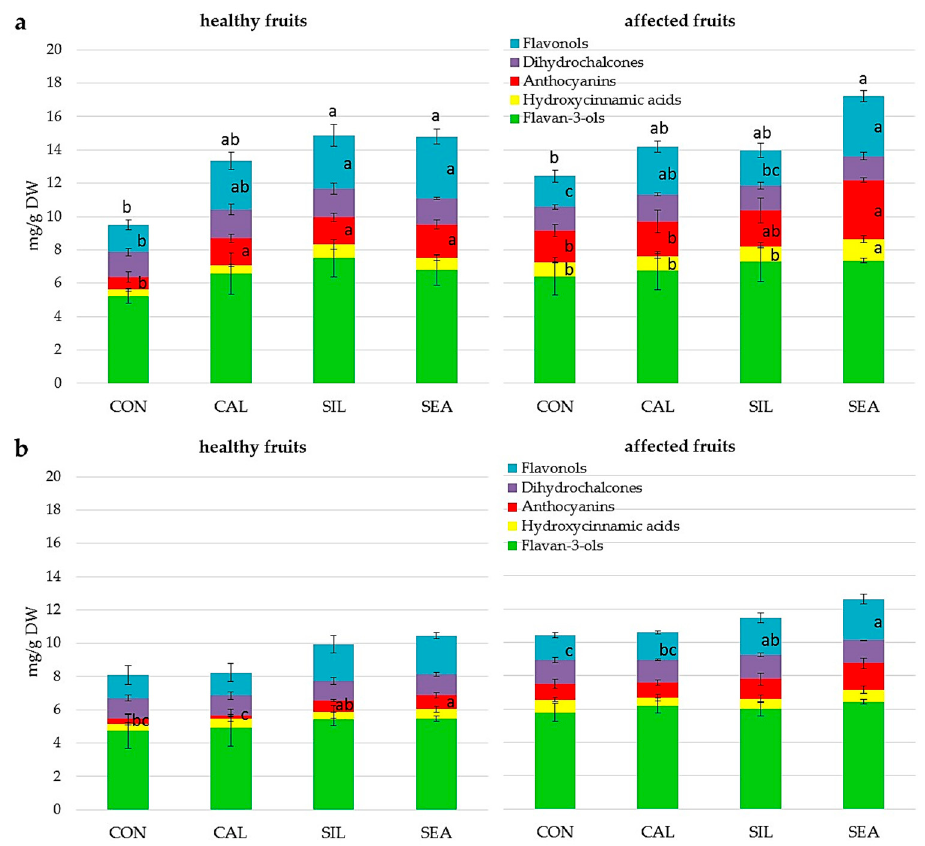
Figure 5. Phenolic content in apple skin after storage in healthy and affected fruits in site 1 ( a ) and site 2 ( b ). Vertical bars indicate mean ± SD ( n = 3). Letters inside bars refer to significant differences among treatments for each single phenolic class, according to Tukey’s HSD post-hoc test; p < 0.05. Letters on the top of the bar indicate significant differences among treatments for total phenolic content, according to Tukey’s HSD post-hoc test; p < 0.05.